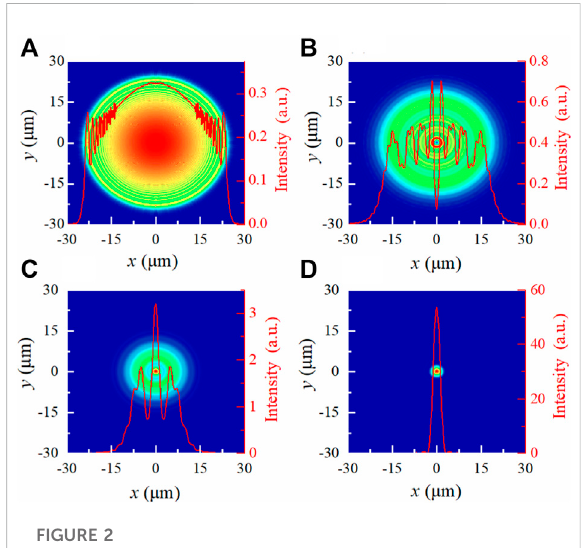
FIGURE 2 (Color inline) Evolution intensity patterns and the corresponding cross-section intensity pro fi les with the initial partial Gaussian beam [as shown in Figure 1B] at the distances (A) z (cid:2) 0 . 007mm; (B) z (cid:2) 0 . 091mm; (C) z (cid:2) 0 . 183mm; and 1 3 2 (D) z 4 (cid:2) 0 . 275mm. Here, n 0 (cid:2) 1 . 46, Δ ≈ 0 . 01, and n 2 (cid:2) 1 . 2 × 10 22 m 2 · v − 2